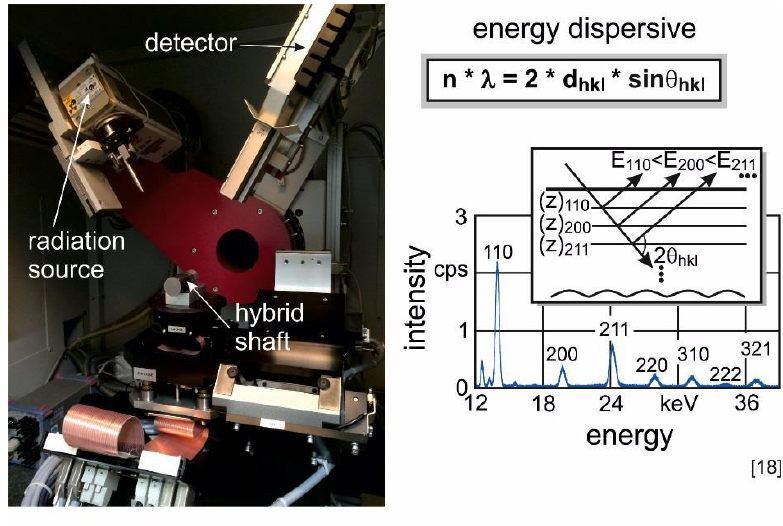
Figure 4. Energy-dispersive residual stress determination method.